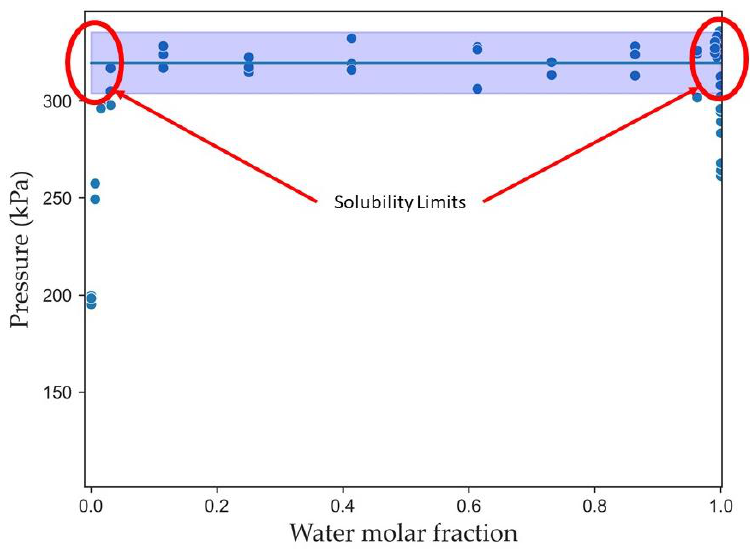
Figure 16. Solubility limit regions for water/octane at 110 °C.